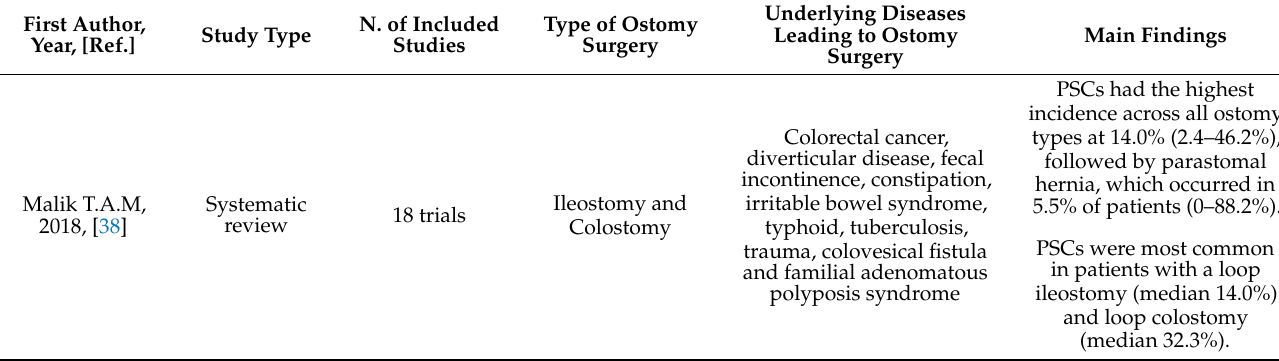
Table 1. Main characteristics and findings on PSCs of the systematic review included in our